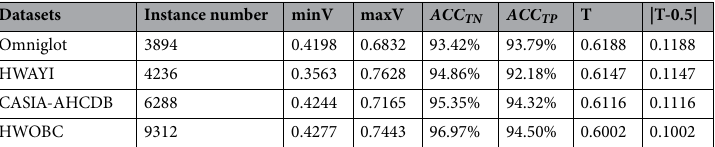
Table 4. The character rejection performance of our method on four datasets. “minV”: min similarity value in known categories. “maxV”: max similarity value in unknown categories. “T”: the rejection threshold (the ideal threshold is 0.5).